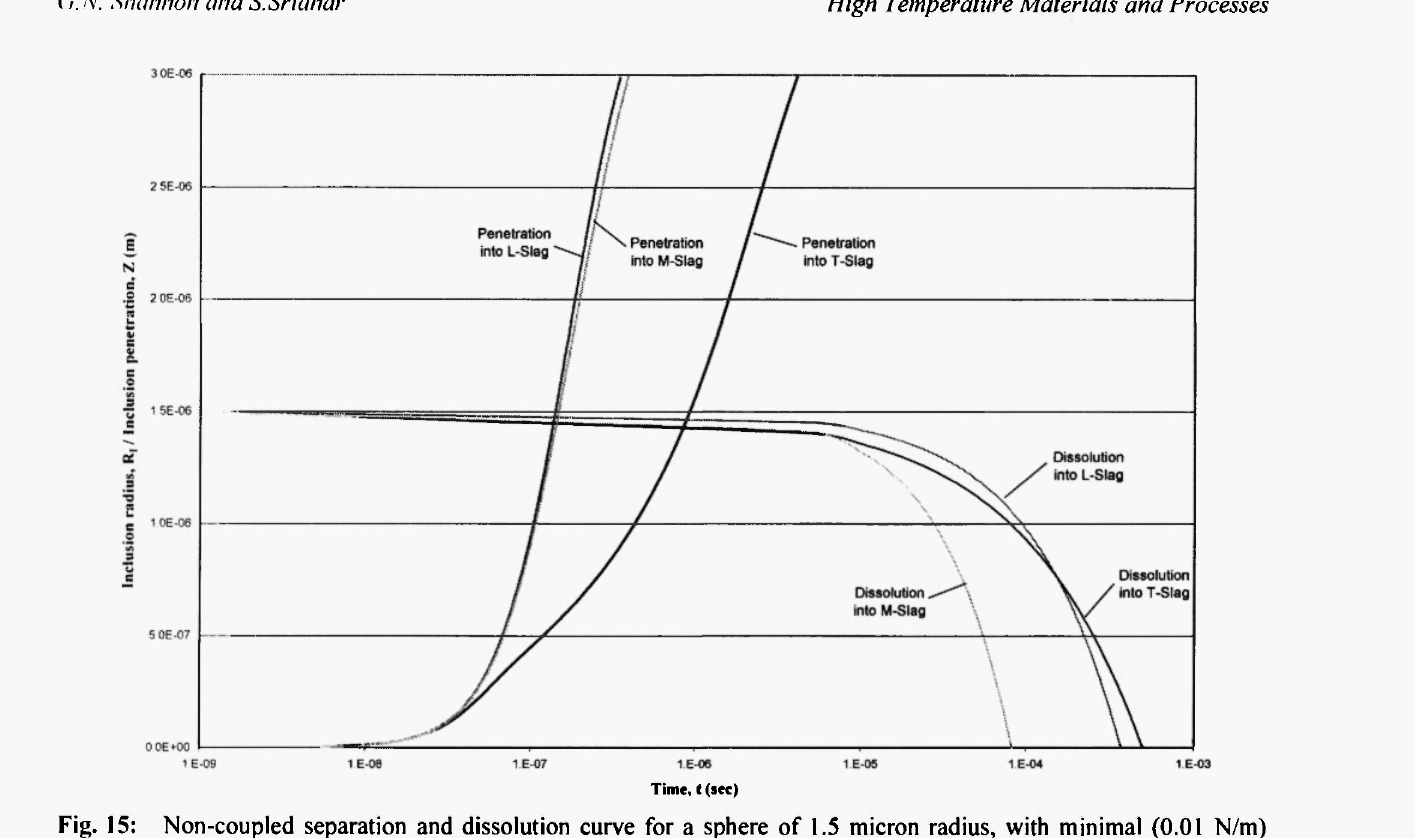
Fig. 15: Non-coupled separation and dissolution curve for a sphere of 1.5 micron radius, with minimal (0.01 N/m) slag/inclusion interfacial energy.